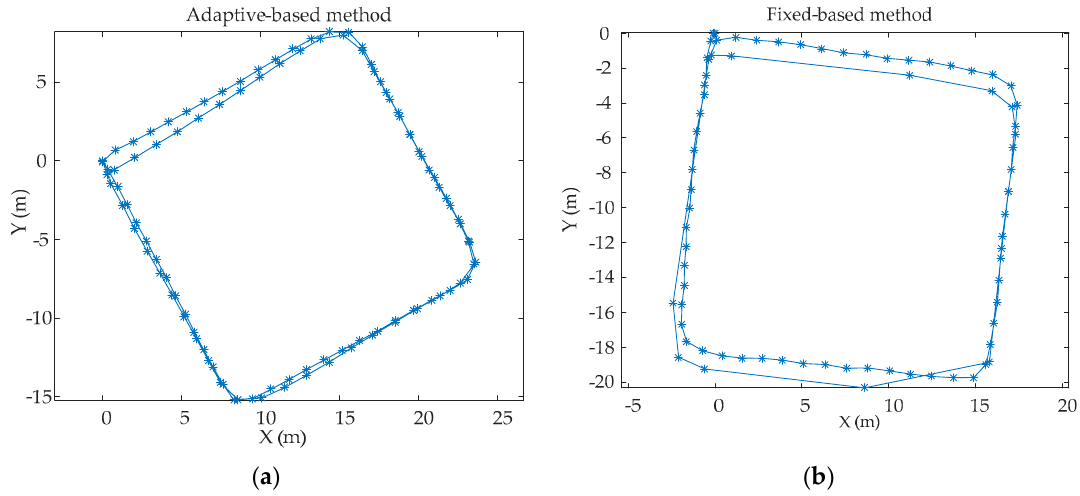
Figure 10. The trajectories of Person B: ( a ) the trajectories using the adaptive zero-velocity detection algorithm; ( b ) the trajectories using the fixed threshold-based algorithm. Table 3. The final positioning errors.